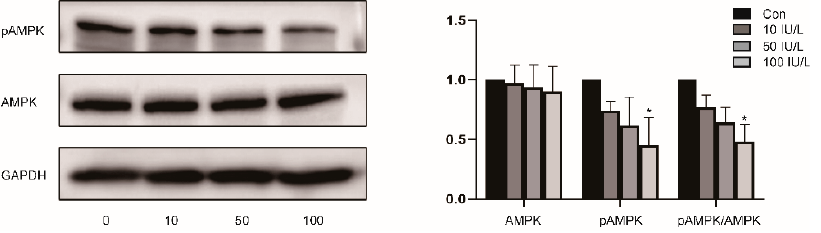
Figure 3. The effect of FSH on AMPK in Ishikawa cells. (Left) AMPK and pAMPK (Thr172) protein levels were detected by WB. (Right) Relative band intensities were used to quantify the level of AMPK and pAMPK (Thr172) protein expression. Data are expressed as means ± SDs. * p < 0.05. FSH promotes neoplasia of endometrial cancer in nude mice.